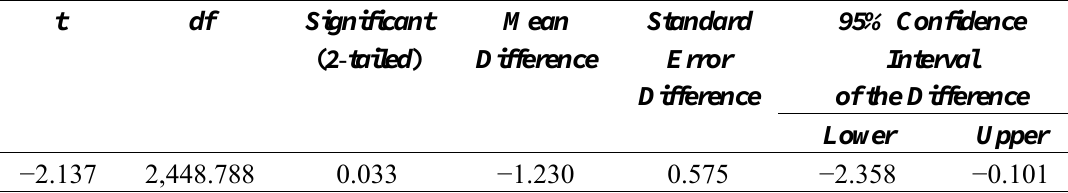
Table 2. T - test for equality of mean values (H1).